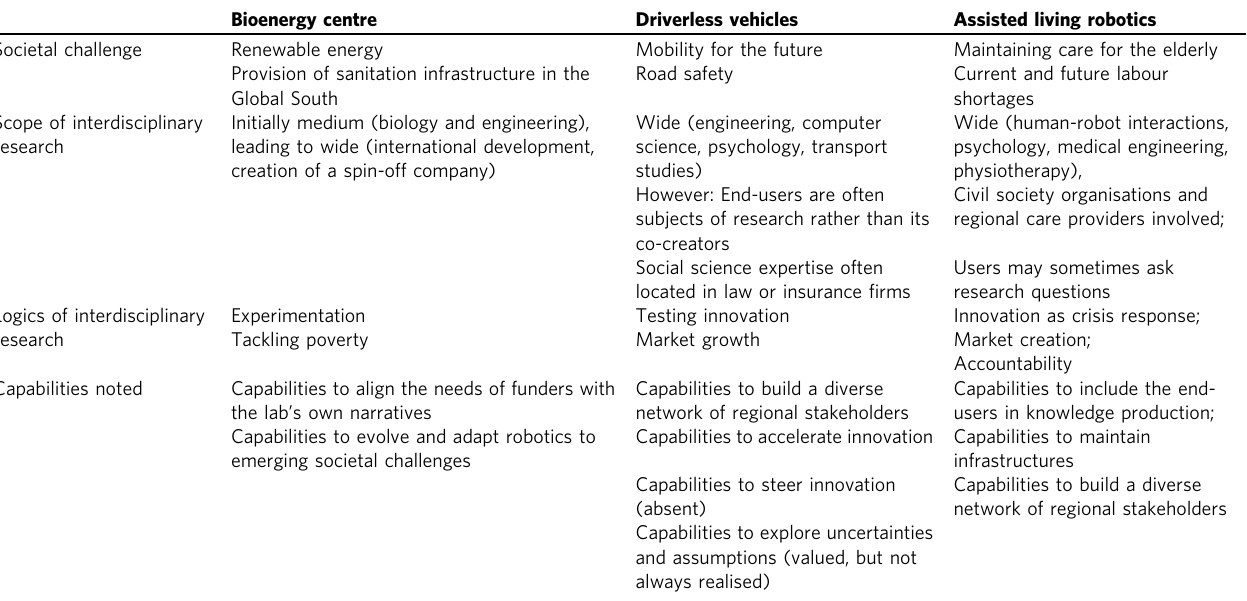
Table 5 Summary of interdisciplinary research politics across three research